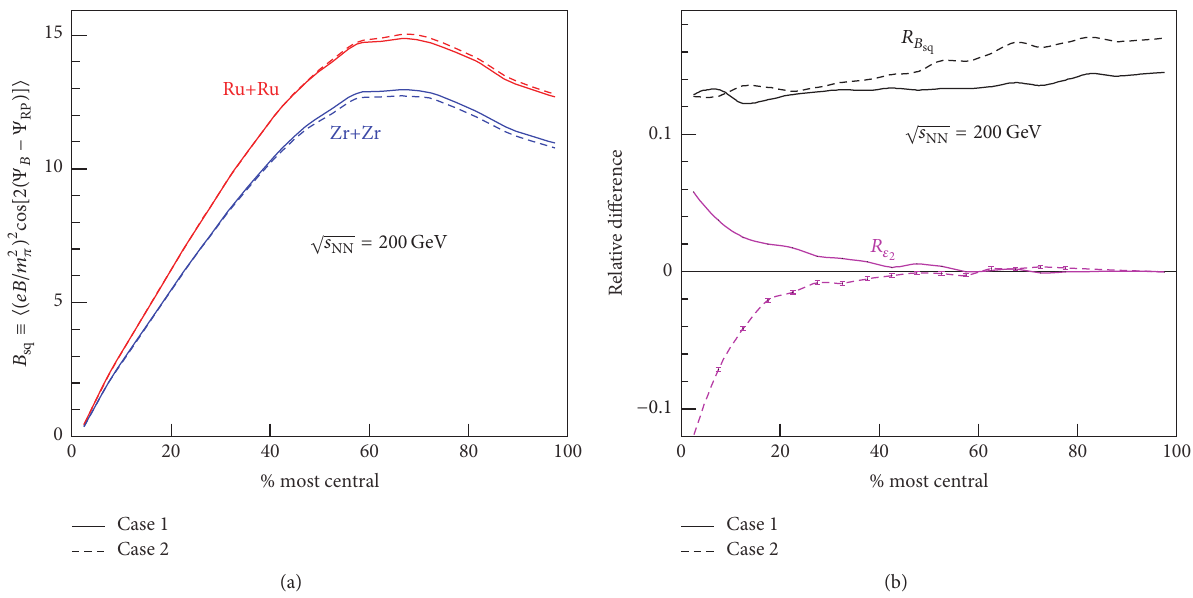
Figure 20: Theoretical calculation [83] of the initial magnetic field squared with correction from azimuthal fluctuation for Ru+Ru and Zr+Zr collisions at 200 GeV (a) and their relative difference (b) versus centrality. Also shown is the relative difference in initial eccentricity (b). The solid (dashed) lines correspond to the parameter set of case 1 (case